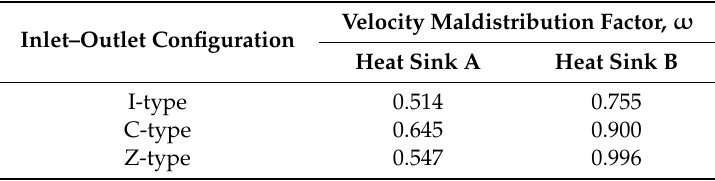
Table 4. Values of ω for di ff erent inlet–outlet